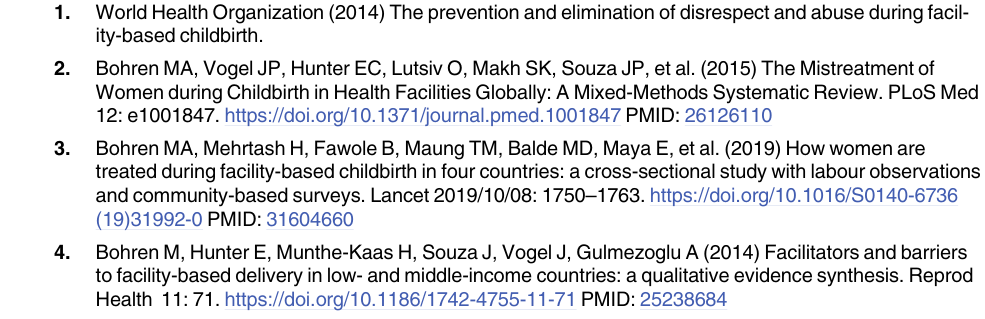
S1 Table. Indicators for mistreatment during childbirth in health facility, according to type of